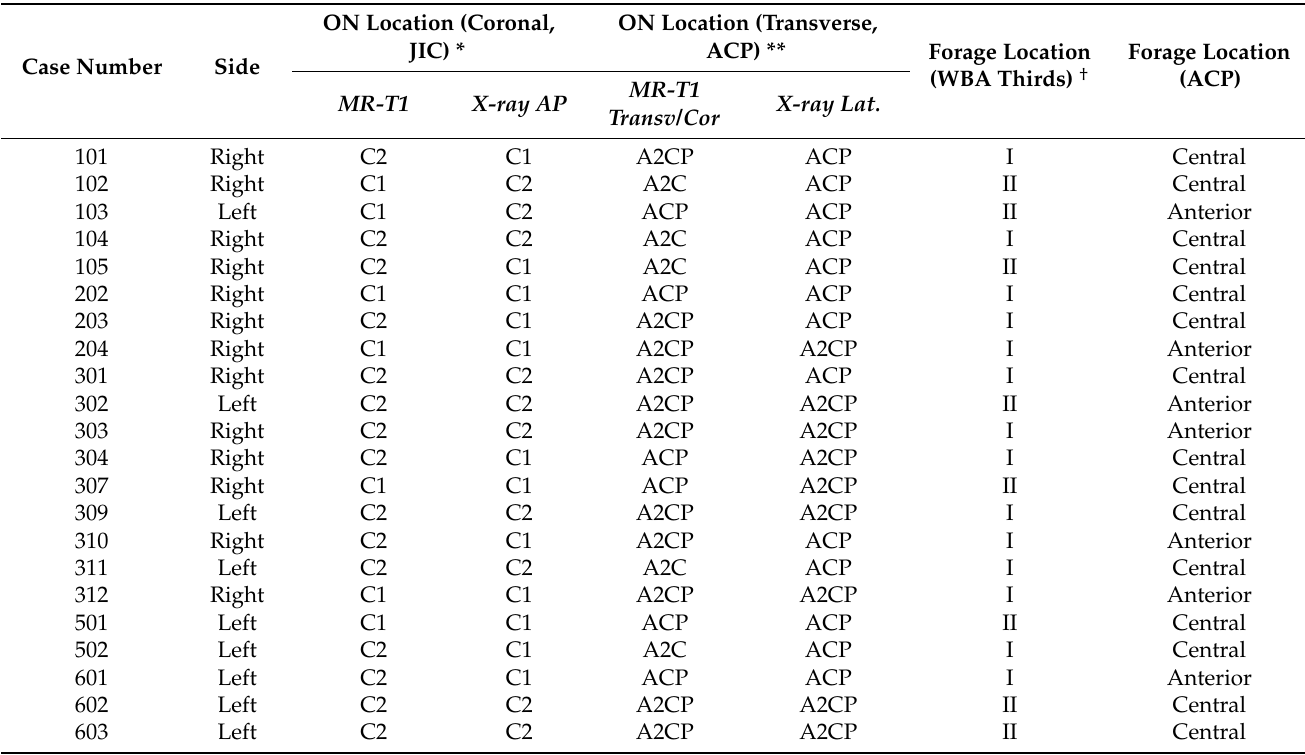
Table 1. Classification of the osteonecrosis and forage based on the location of the lesion in the weight-bearing area (coronal) and on the ACP method (transverse).